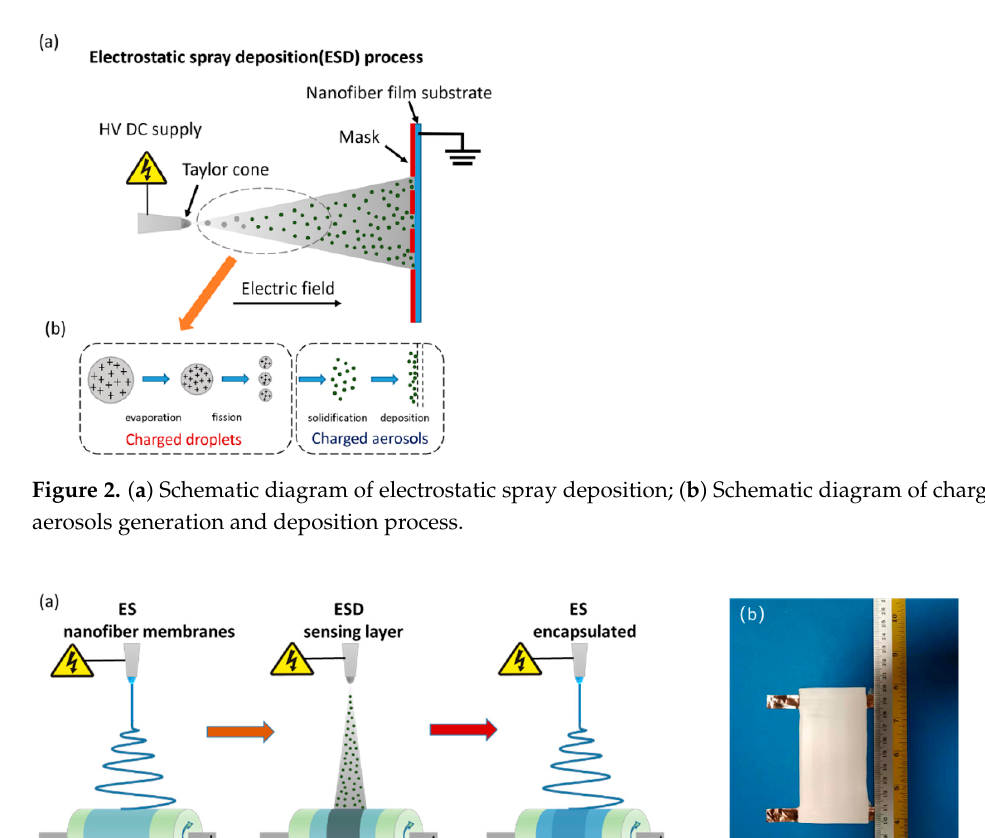
Figure 3. ( a ) Schematic illustration of the fabrication process of the strain sensor; ( b ) Photographs of an ESD-ES strain sensor.